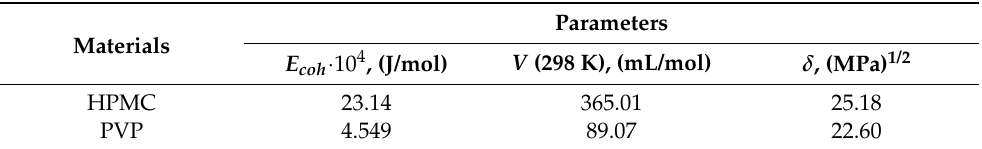
Table 3. Bicerano formalism parameters used in the calculation of HPMC and PVP solubility